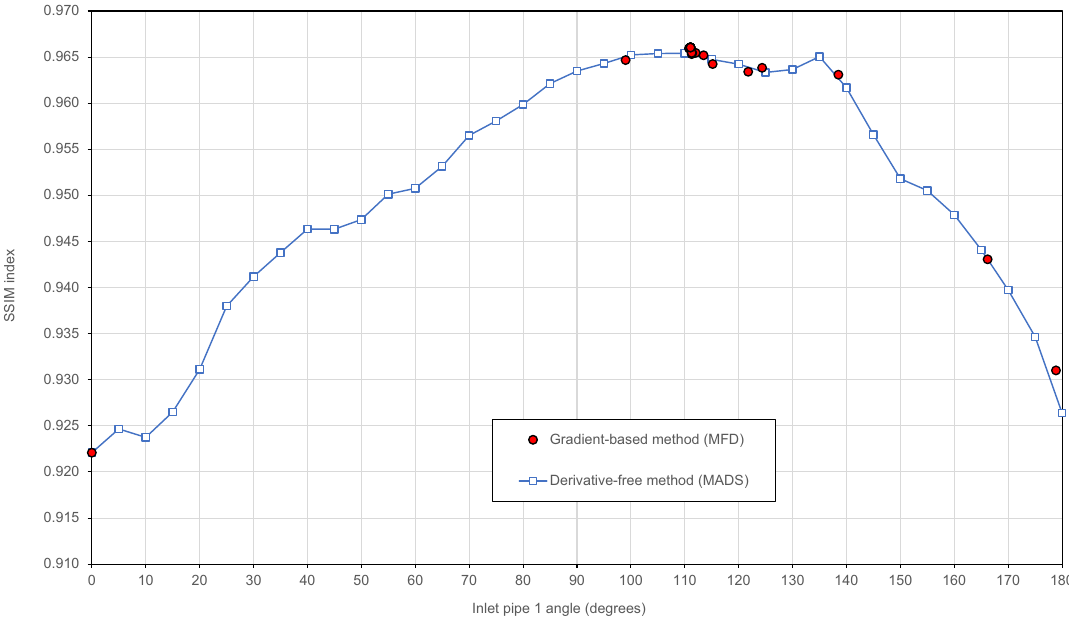
Figure 10. Comparison of the outcome of the DO and DSE studies. The QoI used was the SSIM